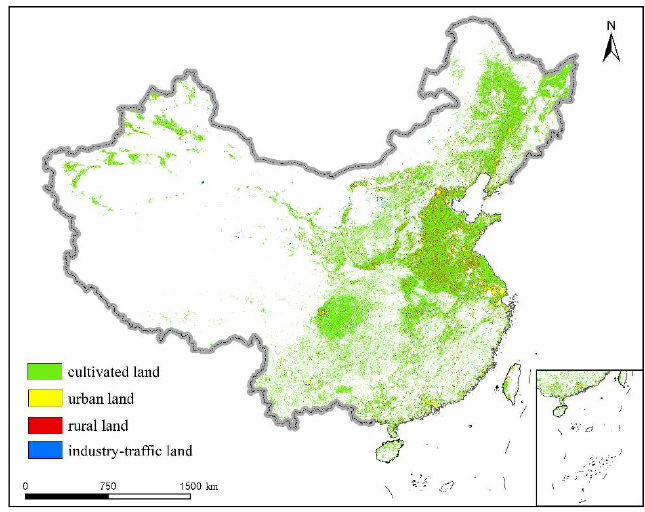
Figure 3. Land use data classification for 2020.